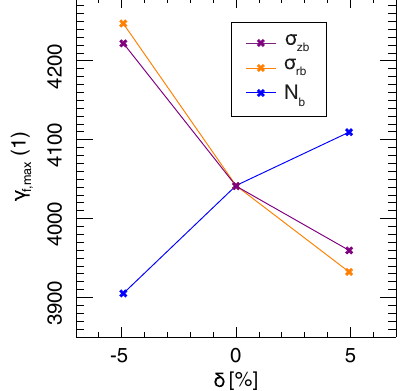
FIG. 9. Maximum final energy γ f; found through the 1D max diagnostic of Fig. 8(a) for three different parameter variations ( δ ¼ 0 corresponds to the baseline